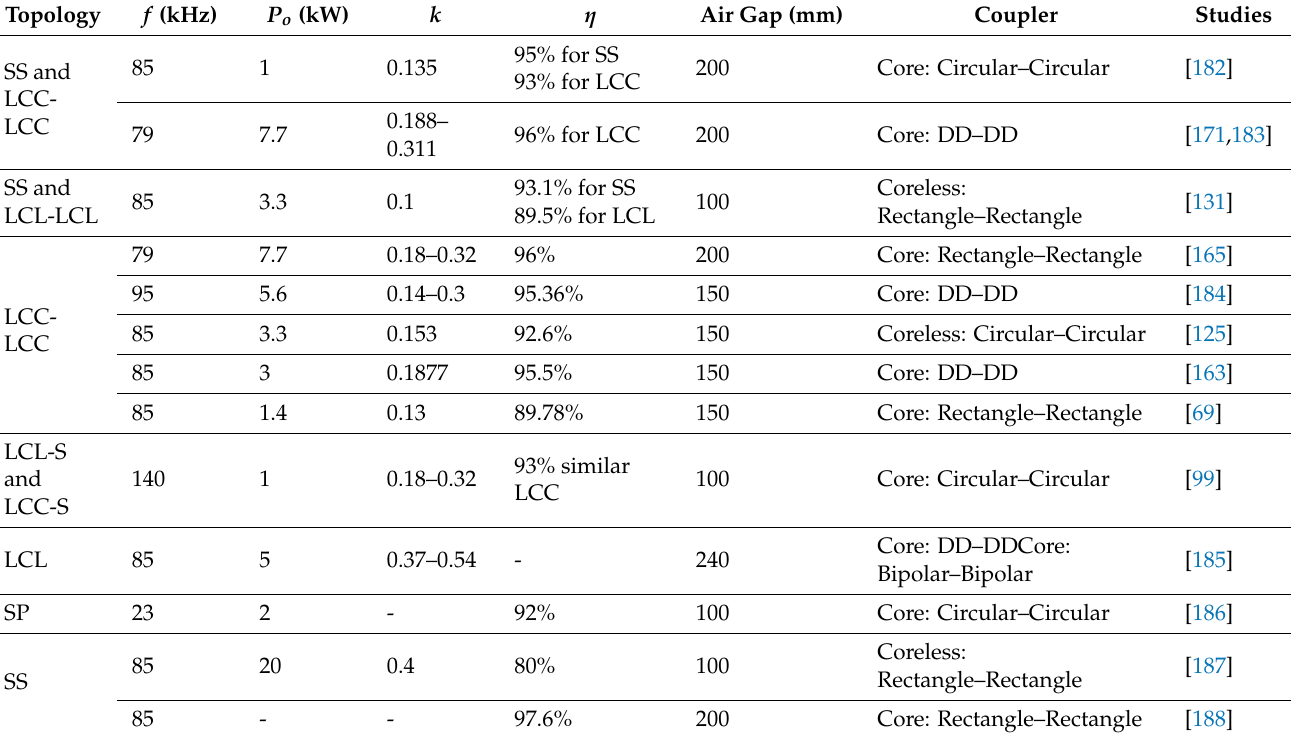
Table 6. Different WPT systems based on compensation